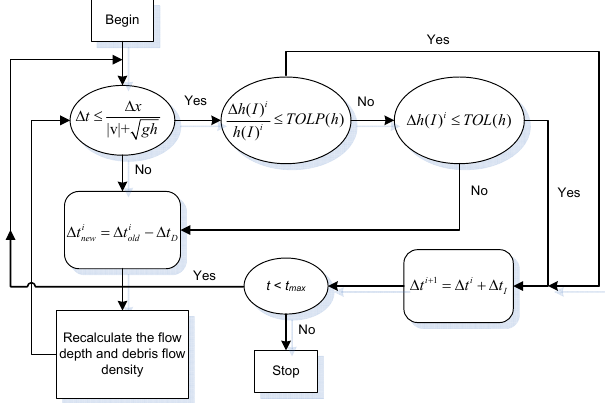
Figure 6. Algorithm for adaptive time stepping. I : cell I ; (cid:49)h(I) i : change of flow depth of cell I during time step i ; h(I) i : flow depth of cell I during time step i ; TOL P(h) : tolerable value of percent change of flow depth during a time step; TOL( h ): tolerable value of change of flow depth during a time step; (cid:49)t I : increment of time step; (cid:49)t D : decrement of time